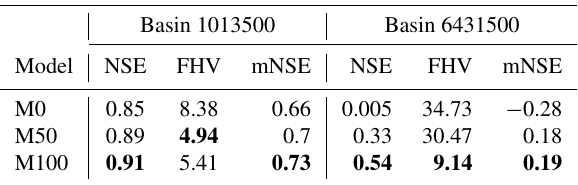
Table 1. Streamflow prediction performance based on NSE (opti- mum: 1), FHV (optimum: 0) and mNSE (optimum: 1) of the con- ceptual model (M0) and both neural ODE models (M50 and M100) for basins 1013500 and 6431500. Bold values indicate best perfor-